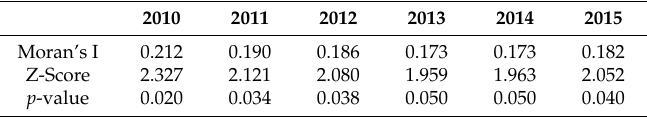
Table 2. NO x emissions’ Global Moran’s I statistics.